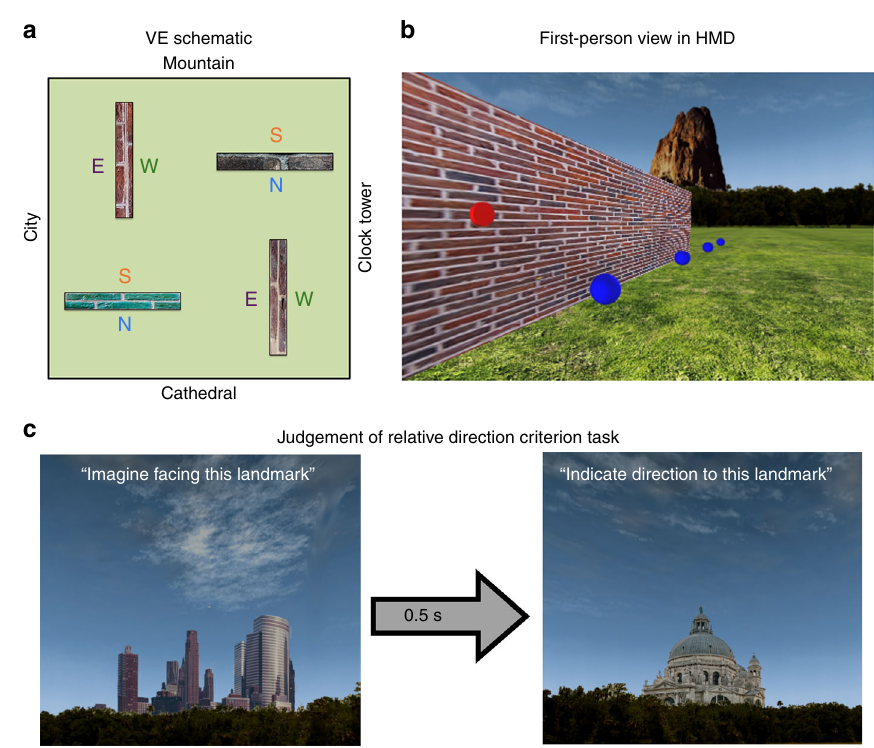
Fig. 3 Schematic of the VE and criterion task during learning phase. a The VE comprised four boundaries, each with a unique texture. The long axis of two of the boundaries spanned North-South, and two spanned East – West. The VE was surrounded by four global landmarks rendered at in fi nity that provided information regarding cardinal direction in the environment. Each side of the boundary created an allocentric boundary either to the North (N), South (S), East (E), or West (W). b In the learning phase the participant wore an HMD and controlled their orientation by physically rotating on the spot whereas translations were controlled via a button press. During exploration, the participant was required to collect all blue tokens and activate all red sensors located on the different sides of the boundaries. c After exploring the environment, the participant completed a JRD task in which they were presented with one of the four global landmarks and asked to indicate the relative direction to another global landmark; the landmarks shown here are the City (pictured to the left) and Cathedral (pictured to the right). Participants were allowed to move on to the scanned test phase only after answering all JRD